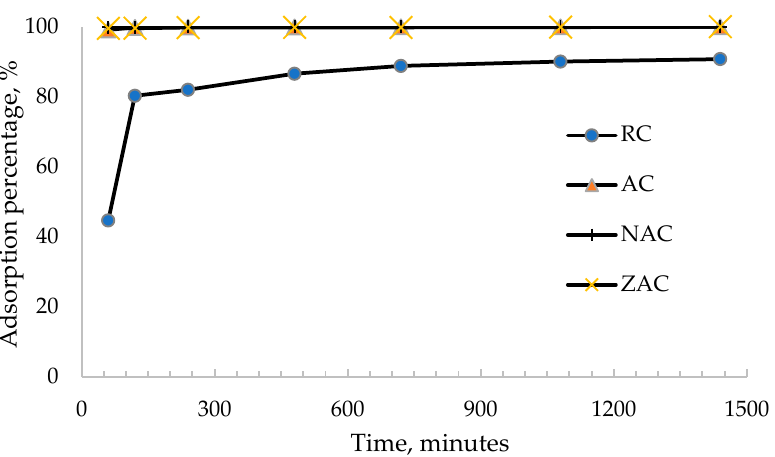
Figure 7. The plot of the adsorption percentage of ofloxacin onto all types of cassava stem adsorbents against different contact times (pH 5; initial ofloxacin concentration = 100 PPM; temperature = 35 °C; adsorbent dosage = 1.5 g/L).